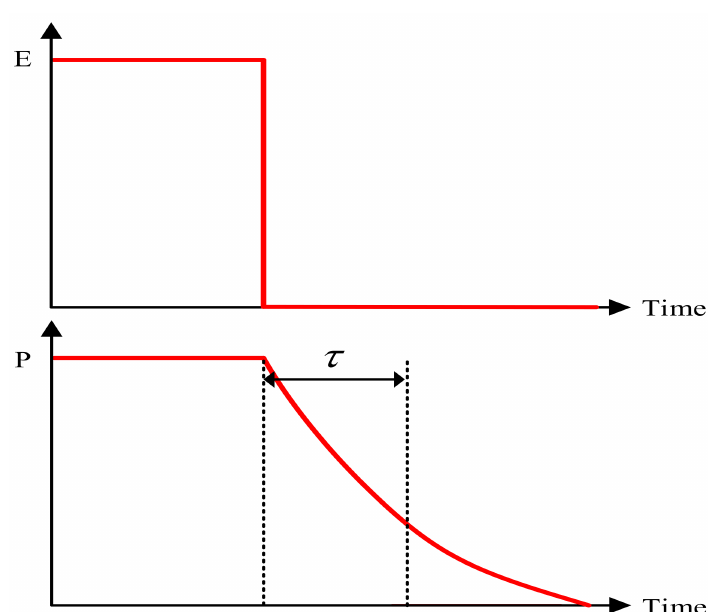
Figure 5. Frequency dependence of electrical